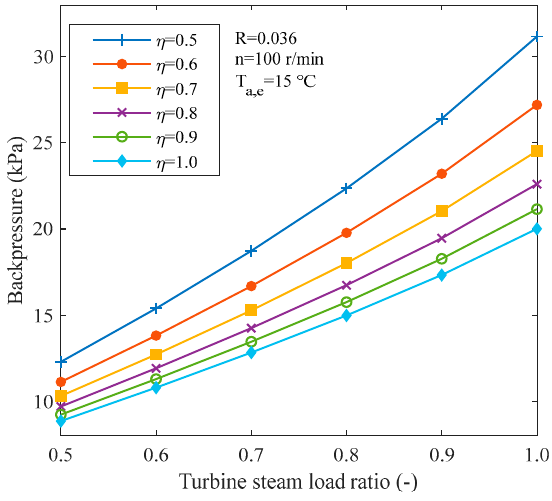
Figure 8. Backpressure at different load ratios and fan volumetric effectiveness.